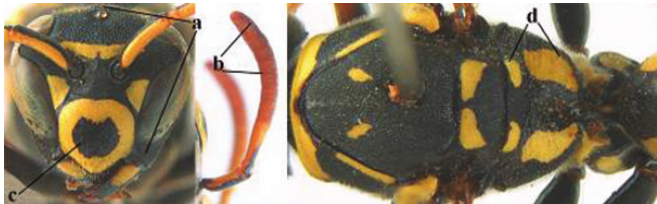
18 Malar space 0.85–1.0 times as long as POL (a); distal half of antenna slightly darker dorsally (b); clypeus with central black patch, may lack in few specimens (c); metanotal and propodeal spots as in (d) [yellow dorsal spot of hind coxa large to absent; hind tibia dorsally with dark brown patch and at both, inner and outer side often with small preapical brown spot; yellow bands of sternites IV-V often medially interrupted; distinct difference in sculpture between mese- pisternum and epicnemium (= epicnemial ridge distinct)]; N Italy to SE Europe, Turkey and Central Asia ............................................. P. foederatus Kohl, 1898